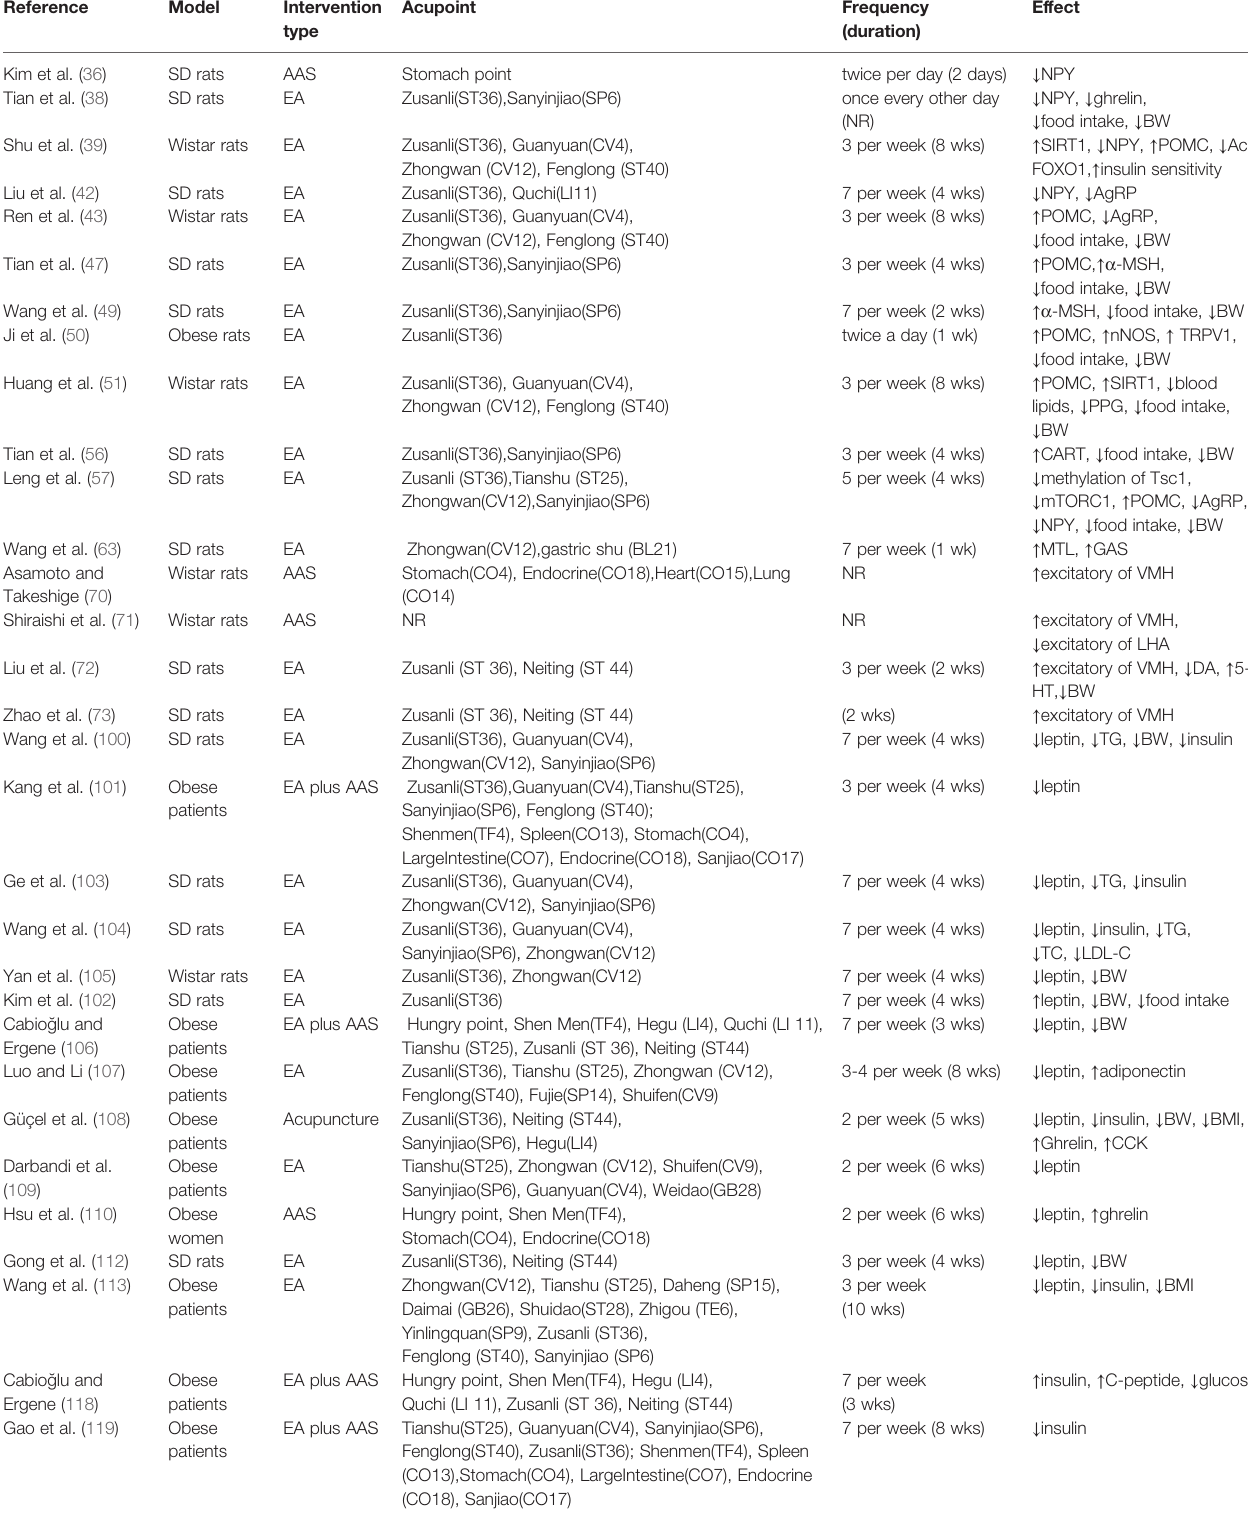
TABLE 1 | Characteristics of acupuncture in the treatment of obesity derive from main studies included.